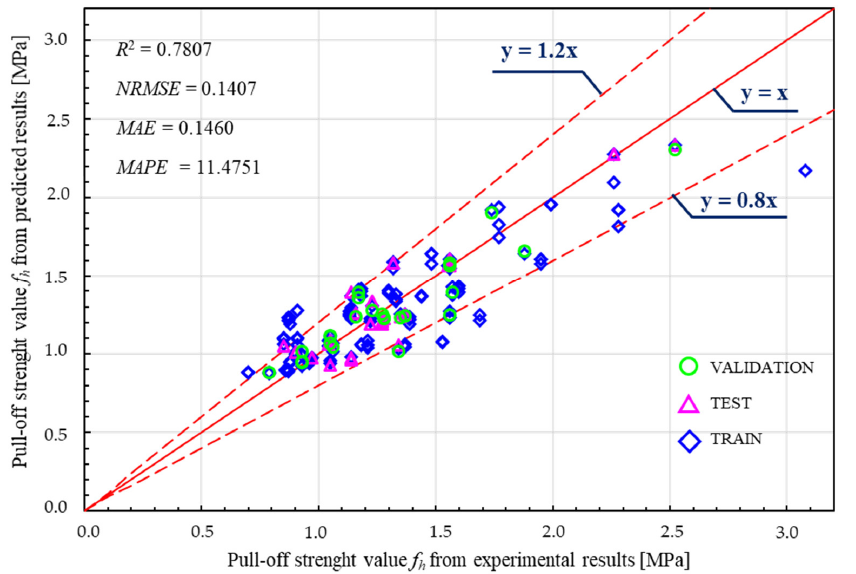
Figure 7. Relationship between the predicted value and the experimental value of the pull-off strength f h for ANN test, train, and validation process for the GD algorithm with one layer of hidden neurons.